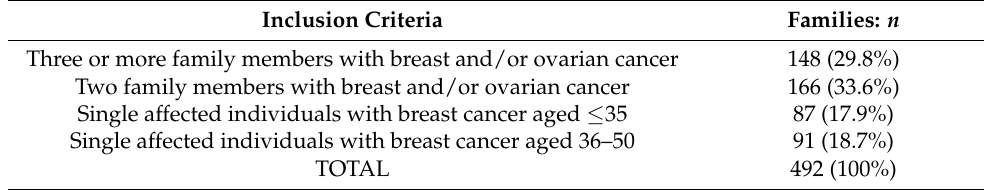
Table 3. Inclusion criteria for study